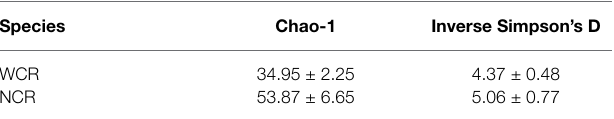
TABLE 1 | Average alpha diversity metrics of western corn rootworm (WCR) and northern corn rootworm (NCR) collected from different locations across the United